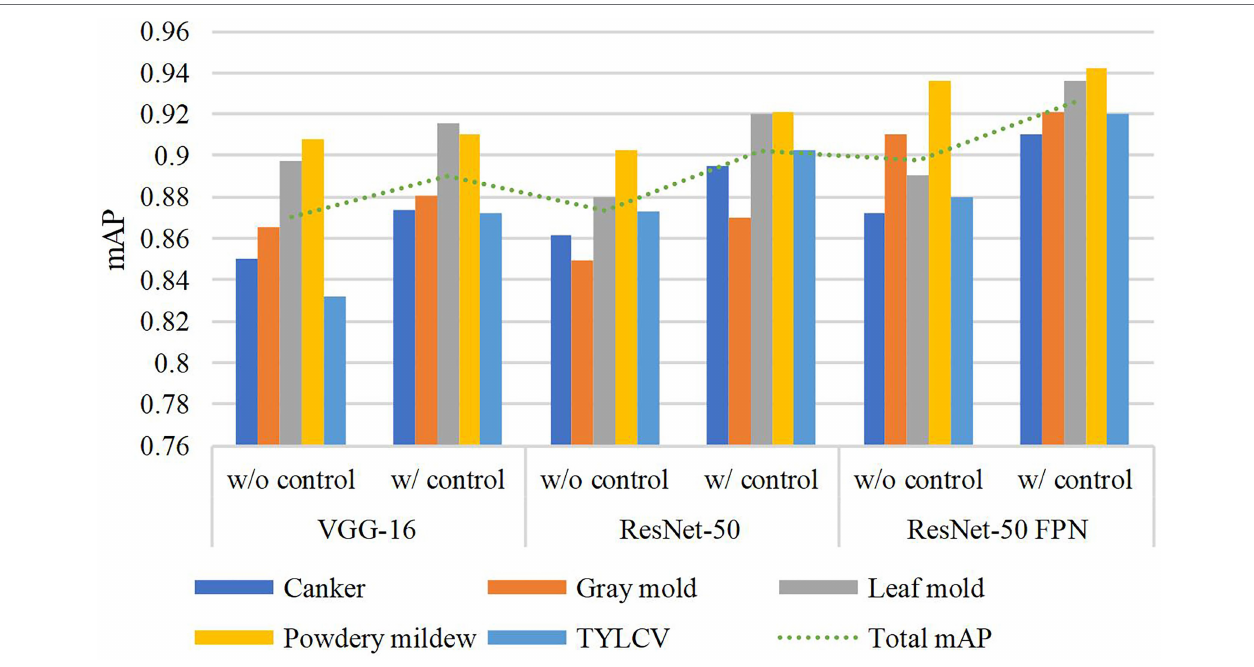
FIGURE 4 | Performance differences with and without using control classes. A certain gain in mean average precision (mAP) is observed after adding the control classes along the target classes during training. Different feature extractors are evaluated in this